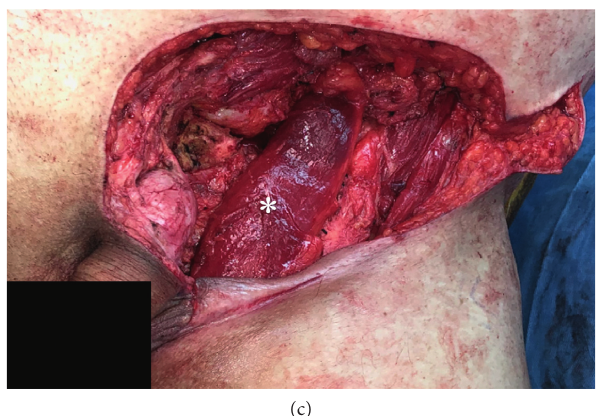
Figure 3: Case example: inguinal sarcoma reexcision and reconstruction. The images (a–c) and photos are of a 57-year-old male with a high- grade soft tissue sarcoma of the left groin who was referred to our institution after incomplete inguinal sarcoma excision during hernia surgery. (a) Axial T1 images of a pelvic MRI prior to reexcision surgery demonstrate a subfascial solid mass ( ∗ ) of the left inguinal region. (b) Wide reexcision specimen is shown, which included abdominal wall resection and left hemiscrotectomy/orchiectomy performed with multidisciplinary coordination between orthopaedic oncology, surgical oncology, and urology. (c) The resultant left groin soft tissue defect was covered with a rotational gracilis flap ( ∗ ) to protect the iliac vessels, and an acellular dermal matrix strattice with local tissue rearrangement (not